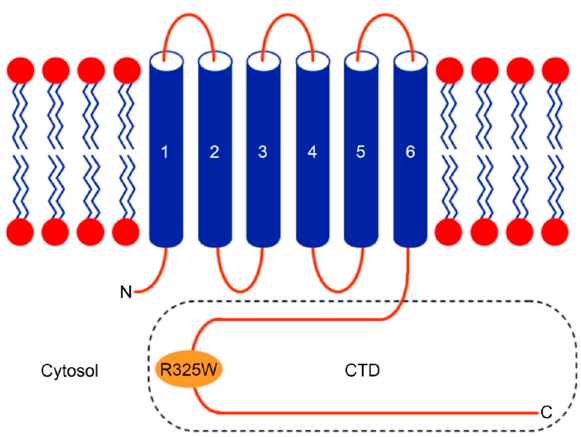
Figure 1. Cartoon diagram of the human zinc transporter 8 (hZnT8) protein topology depicting the location of the R325W substitution in the C-terminal domain (CTD). Like many other Zn + 2 transporters (ZnTs), hZnT8 consists of a transmembrane domain (TMD), with its N- and C-termini facing the cytoplasm [8].